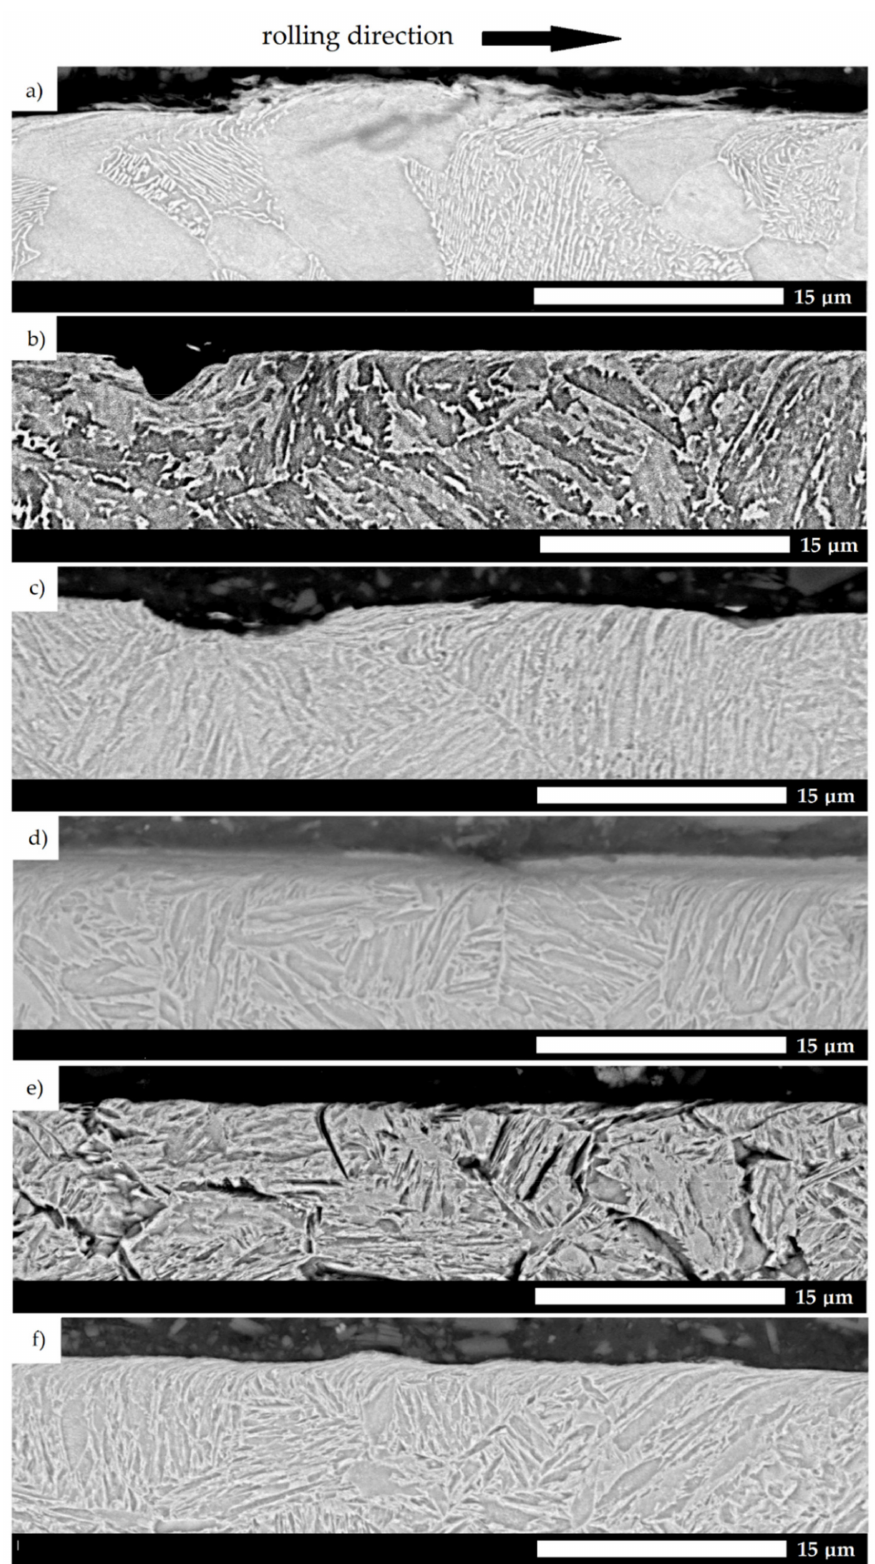
Figure 12. Sub-surface microstructures taken longitudinal to the direction of abrasive action. ( a ) 38GSA (N); ( b ) Creusabro 4800; ( c ) Creusabro 8000; ( d ) TBL PLUS; ( e ) XAR 600; ( f ) 38GSA (HT). SEM, etched with 5% HNO 3